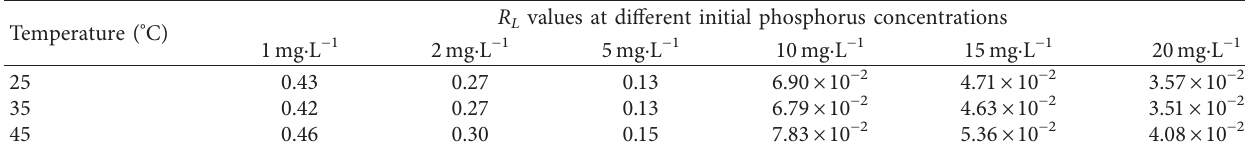
Table 5: The R L values at different initial phosphorus